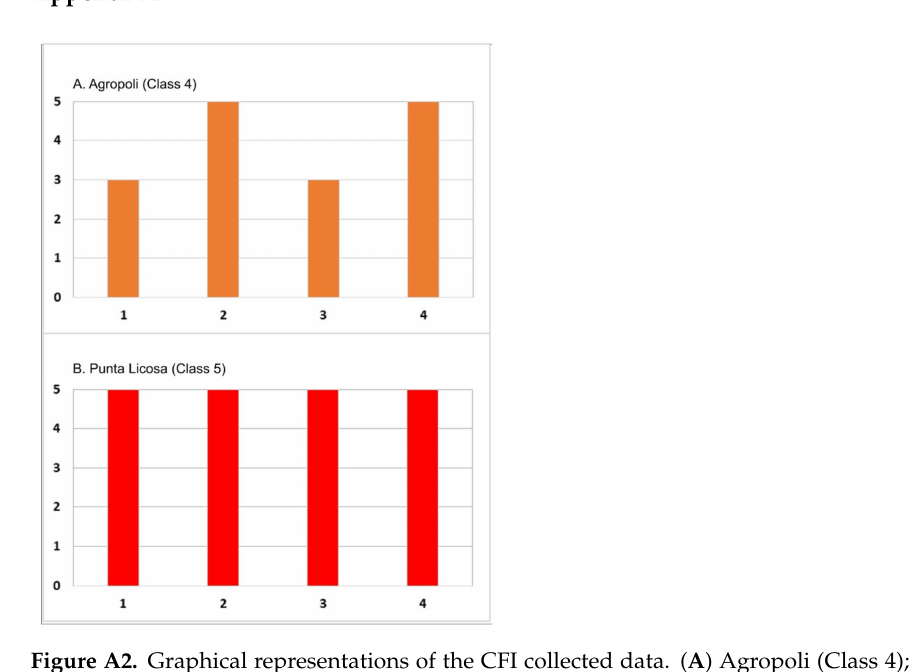
Figure A2. Graphical representations of the CFI collected data. ( A ) Agropoli (Class 4); ( B ) Punta Licosa (Class